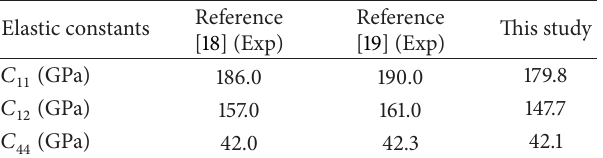
Table 1: Comparing previous experimental results and present calculation data for 𝐶 11 , 𝐶 12 , and 𝐶 44 constants of Au.